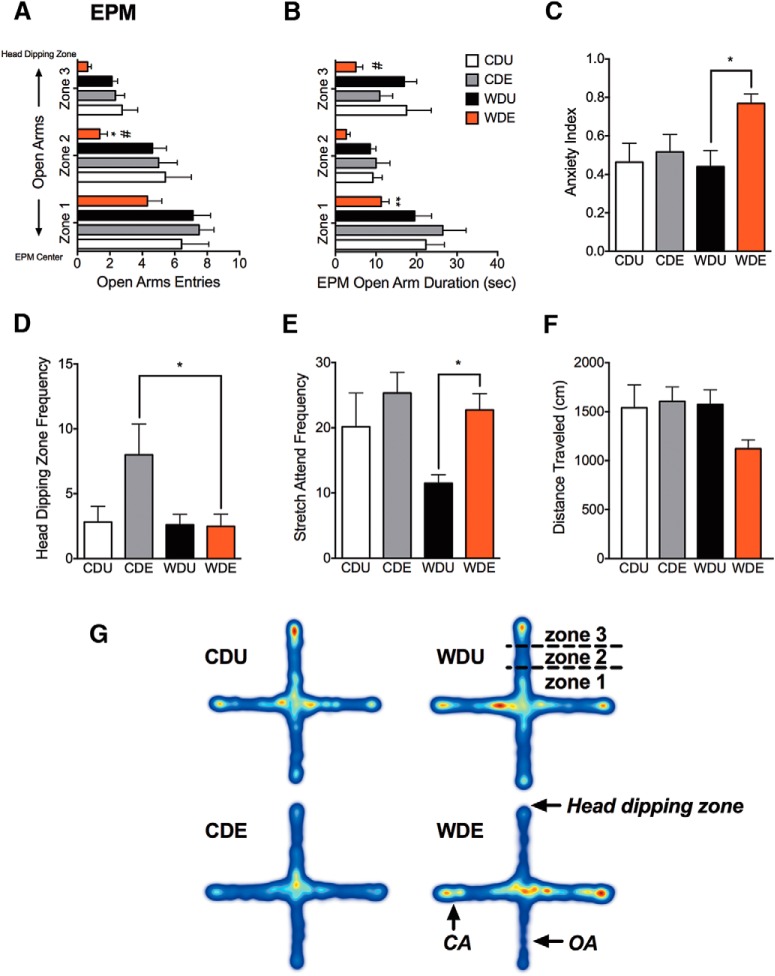
WD increases anxiety-like behaviors in the EPM following PS. Each open arm was subdivided into three zones (zone 1, proximal; zone 2, medial; zone 3, distal) to eliminate false-positive results in arm entry statistics. A, The diet type significantly affected the number of entries to the medial section of the open arms (diet: F(1,24) = 4.68, p = 0.041). WDE rats showed a reduced number of entries to zone 2 and zone 3 of the open arms when compared with CDE rats (p < 0.05). PS exposure (F(1,24) = 3.23, p = 0.085) or diet–PS exposure interactions (F(1,23) = 1.93, p = 0.18) did not affect the number of entries to the medial zone of the open arms. B, Notably, we found a significant main diet effect on the time the rats spent in the proximal zones of the EPM open arms (for zone 1: F(1,23) = 4.81, p = 0.039). Post hoc testing revealed that WDE rats spent less time in the proximal and medial parts of the open arms when compared with CDE rats (p < 0.05). PS exposure main effects (F(1,23) = 0.25, p = 0.62) or diet–PS exposure interactions (F(1,23) = 2.30, p = 0.14) showed no statistical significance. PS exposure decreased the time spent in the distal zones of the EPM open arms (for zone 3: F(1,23) = 6.59, p = 0.017). Analyses revealed no significant diet (F(1,23) = 0.80, p = 0.38) or diet–PS exposure interactions effects (F(1,23) = 0.55, p = 0.47). C, PS exposure had a significant effect on the EPM index of anxiety (F(1,24) = 5.65, p = 0.026). Post hoc analyses revealed that the PS-exposed rats exhibited an increased anxiety index when compared with controls (WDE vs WDU, p = 0.022). Analyses revealed no significant main effects of the diet (F(1,24) = 2.03, p = 0.17) or diet–PS exposure interactions (F(1,24) = 2.94, p = 0.099) on the anxiety index. D, We found that the diet type significantly affected the frequency of when the nose point of the rats was in the head-dipping areas (F(1,24) = 4.61, p = 0.042). Post hoc comparisons indicated a decreased nose in head-dipping zone frequency in WDE rats when compared with the CDE rats (p < 0.05). PS exposure (F(1,24) = 3.60, p = 0.070) and diet–PS exposure interactions (F(1,24) = 3.96, p = 0.058) did not have a significant effect on head-dipping zone frequency. E, PS exposure increased SAP frequency (PS: F(1,24) = 7.17, p = 0.013). Post hoc testing showed increased SAPs in the WDE rats when compared with WDU rats (p < 0.05). The diet type (F(1,24) = 3.37, p = 0.079) and diet–PS exposure interactions (F(1,24) = 0.98, p = 0.33) did not show significant main effects on SAP frequency. F, We found no significant main effect of diet (F(1,24) = 0.94, p = 0.16), PS exposure main effect (F(1,24) = 1.54, p = 0.23), or interaction between these factors (F(1,24) = 2.76, p = 0.11) on the total distance traveled during EPM testing. G, Heat maps show that WDE rats spent more time in the closed arms when compared with CDE rats. All data are presented as the mean ± SEM. *p < 0.05, **p < 0.01, n = 6–10 rats/group. For A and B: *p < 0.05 or **p = 0.01 for CDE vs WDE; #p < 0.05 for WDU vs WDE.